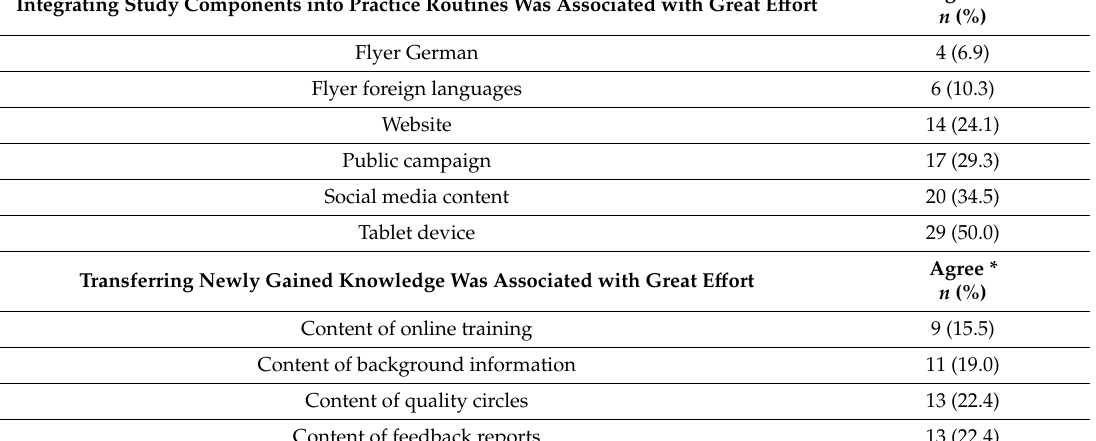
Table 3. Medical assistant (MA) perspective on integrating study components and newly gained knowledge (T2; n =